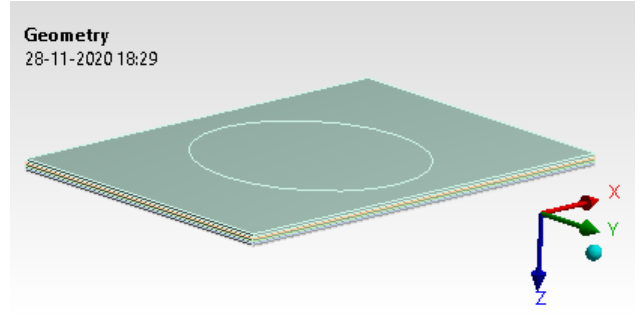
Figure 14. Geometry